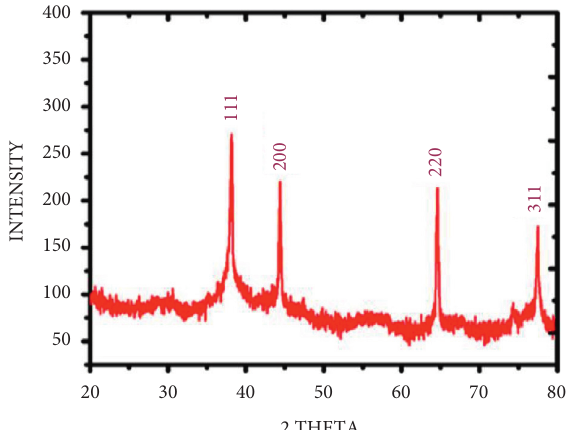
Figure 2: XRD analysis of AgNPs synthesized using B. lanzan Spreng leaf extract.